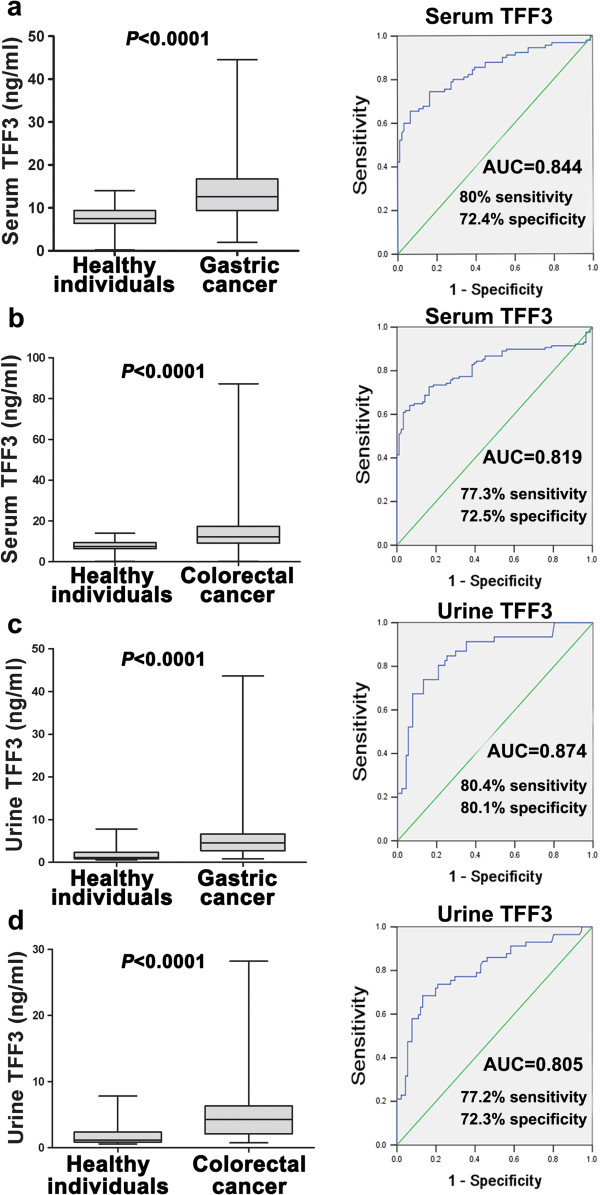
Measurement of serum and urine TFF3 levels and ROC curve analysis. With a serum TFF3 levels cut-off values ≥ 8.98 ng/ml, the sensitivity and specificity of TFF3 to distinguish gastric patients from healthy individuals were 80% and 72.4%, respectively. (P <0.001) (a) With a serum TFF3 levels cut-off values ≥ 8.83 ng/ml, the sensitivity and specificity of TFF3 to distinguish colorectal patients from healthy individuals were 77.3% and 72.5%, respectively. (P <0.001) (b) With a urine TFF3 levels cut-off values ≥ 3.23 ng/ml, the sensitivity and specificity of TFF3 to distinguish gastric patients from healthy individuals were 80.4% and 80.1%, respectively. (P <0.001) (c) With a serum TFF3 levels cut-off values ≥ 2.78 ng/ml, the sensitivity and specificity of TFF3 to distinguish colorectal patients from healthy individuals were 77.2% and 72.3%, respectively (P <0.001) (d).